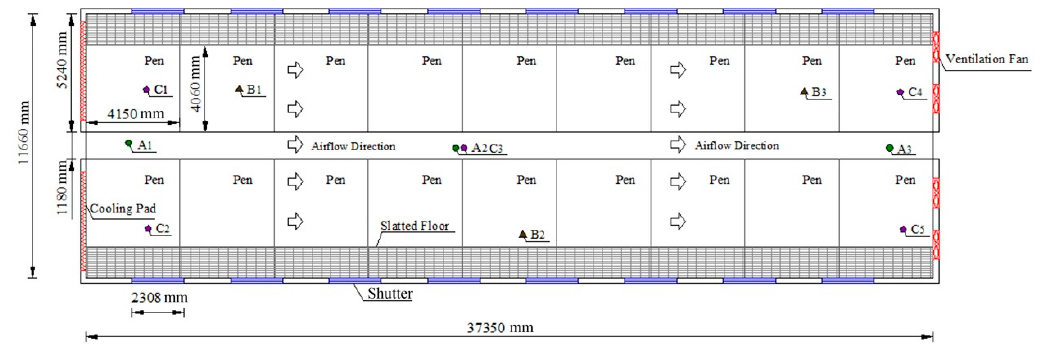
Figure 1. Floor plan and locations of monitoring points in the pig house. A 1 , A 2 , and A 3 are the locations of the total suspended particle (TSP) and ammonia (NH 3 ) measurements, as well as atmospheric pressure monitoring; B 1 , B 2 , and B 3 are the locations of the microbe sampling; and C 1 , C 2 , C 3 , C 4 , and C 5 are the locations of the temperature and humidity monitoring.